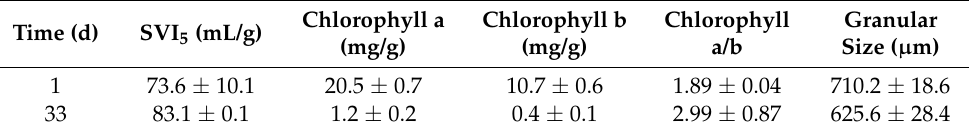
Table 2. Basic parameters of MBGS before and after the